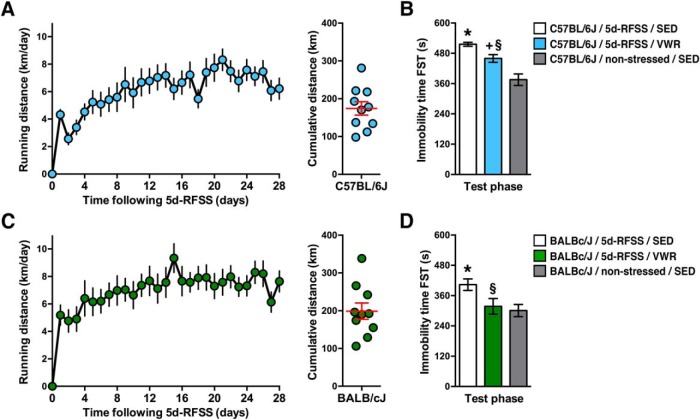
Effects of VWR on the persistence of immobility behavior following 5d-RFSS. A, Daily VWR distance (left; F(27,243) = 5.89, p < 0.00001) and cumulative VWR distance (right) of C57BL/6J mice. B, VWR (28 d) following 5d-RFSS lowered immobility scores during the test day swim session toward levels of nonstressed SED mice (F(2,27) = 18.45, p = 0.00001; post hoc test, *p = 0.00013 vs nonstressed SED mice; +p = 0.0034 vs nonstressed SED; §p = 0.059 vs 5d-RFSS SED mice). C, Daily VWR distance (left; F(27,243) = 4.37; p < 0.00001) and cumulative VWR distance (right) of BALBc/J mice. D, VWR (28 d) following 5d-RFSS normalized immobility scores during the test day swim session to levels of nonstressed SED mice (F(2,27) = 4.41, p = 0.02; post hoc test, *p = 0.026 vs nonstressed SED, §p = 0.068 vs 5d-RFSS SED). n = 10/group for all experiments.